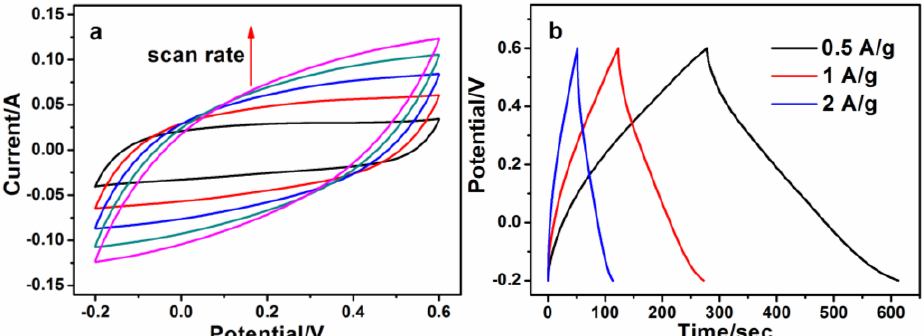
Figure 7. ( a ) CV curves of 50-CDs/rGO (5:1) at different scan rates of 0.2, 0.4, 0.6, 0.8 and 1 V/s, respectively, where the arrow indicates the direction of increasing scan rates; ( b ) GCD curves of 50-CDs/rGO (5:1) at different current densities of 0.5 A/g, 1 A/g and 2 A/g, respectively.